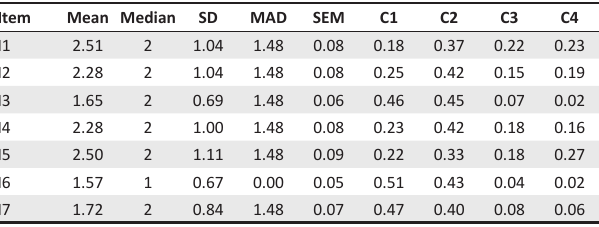
TABLE 1: Item descriptive statistics and response categories